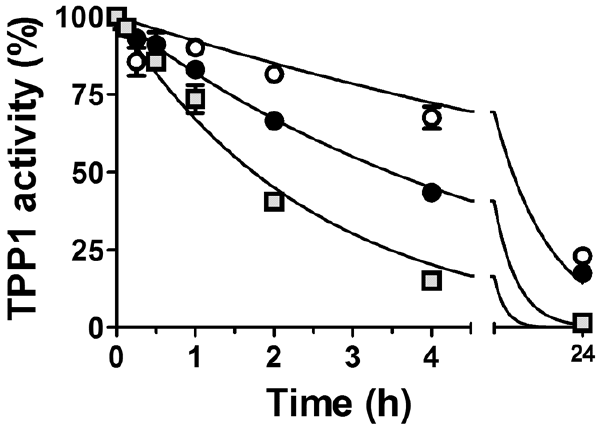
Figure 3. Invitro stability of proTPP1 preparations in plasma. ProTPP1 diluted in aCSF was mixed with plasma from Tpp1 ( 2 / 2 ) mice (final concentration 0.08 mg/mL TPP1, 87.5% plasma) on ice. Time courses were started by incubation at 37 u C and samples frozen at the indicated times. Preparations were then activated and TPP1 activity measured and normalized to the zero timepoint. Unmodified TPP1, open circles; OX-TPP1, filled circles, DG-TPP1, gray squares. Data was fit to a single-phase exponential decay model using Graphpad Prism constraining initial values to 100% and the plateau value to 0%, yielding the following half-life estimates (with 95% confidence limits): unmod- ified TPP1, 8.6 (6.7–11.9) h; OX-TPP1, 3.5 (2.9–4.3) h; DG-TPP1, 1.7 (1.5– 2.1) h.